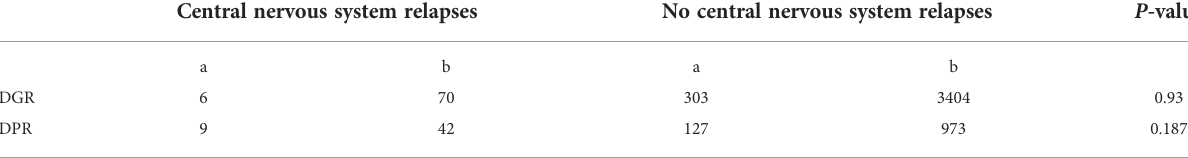
TABLE 6 Relationship between central nervous system relapses and CNS3, CNS2 or the fi rst intrathecal injection injury at the initial diagnosis.